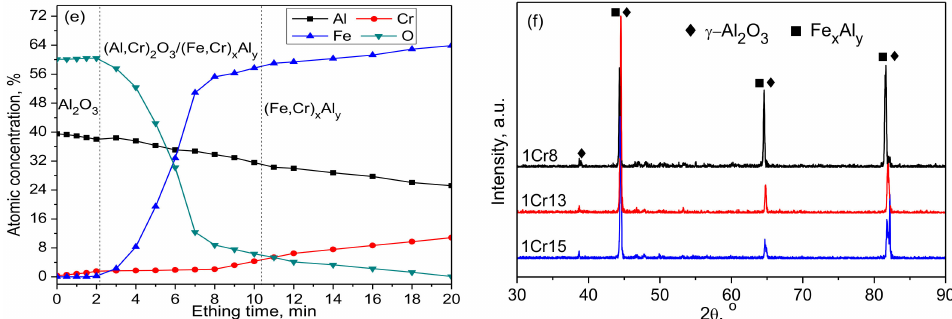
Figure 5. Depth profiles of ( a ) Fe, ( b ) Cr, ( c ) Al, ( d ) O, and ( e ) the relative atomic contents for scales formed on aluminide 1Cr13 steel; and ( f ) XRD patterns for aluminide coatings formed on Cr steel substrates after 700 ◦ C, 120 h selective oxidation in an Ar gas stream.